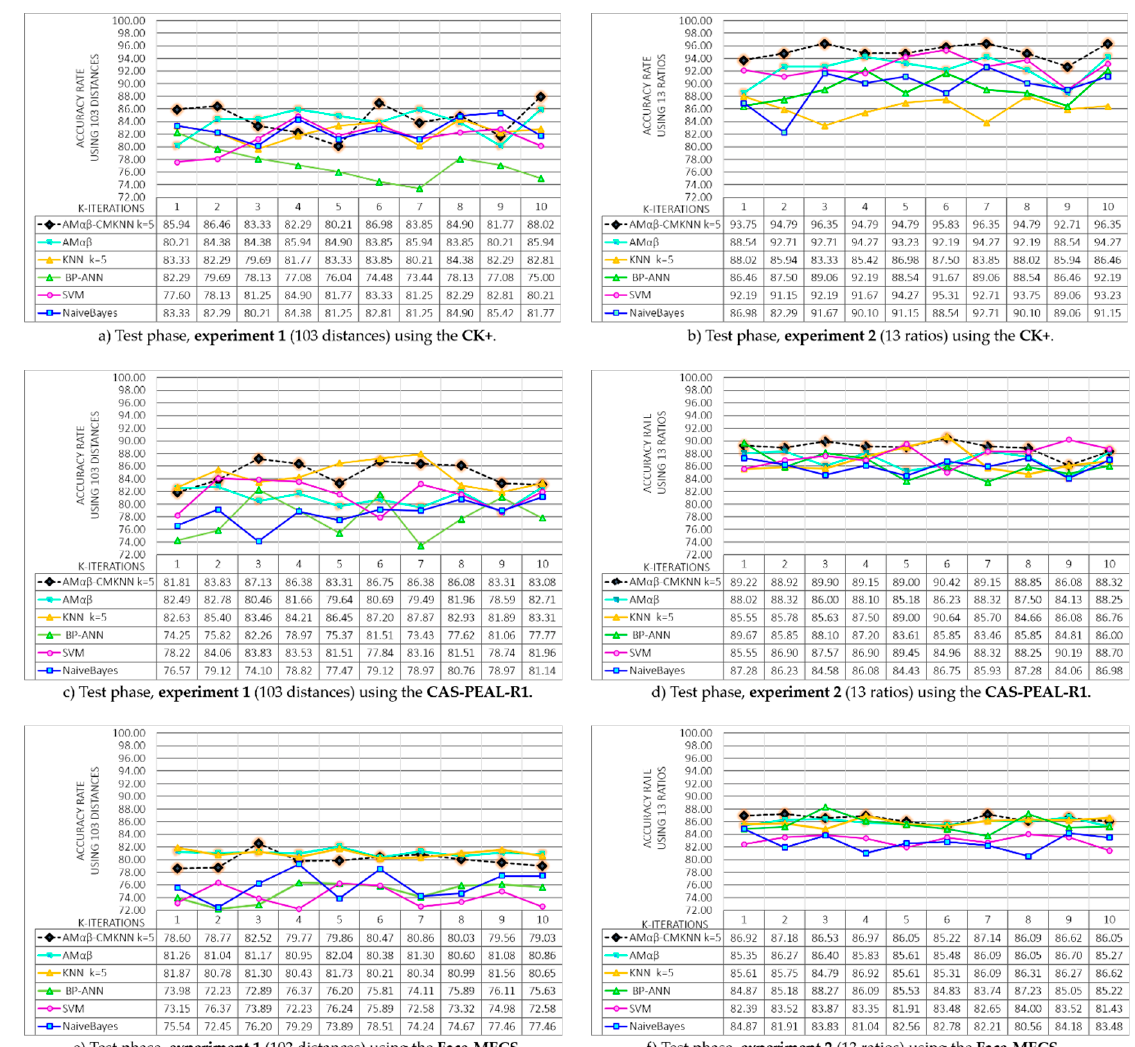
Sensors 2018 , 18 , x FOR PEER REVIEW 19 of